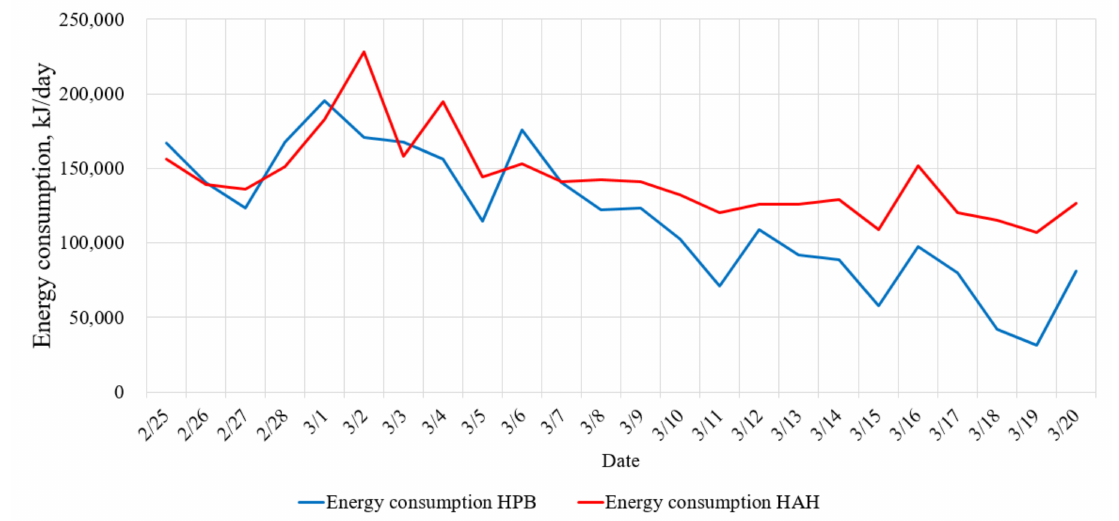
Figure 11. Comparison of greenhouse heating energy consumption between HPB and HAH systems.